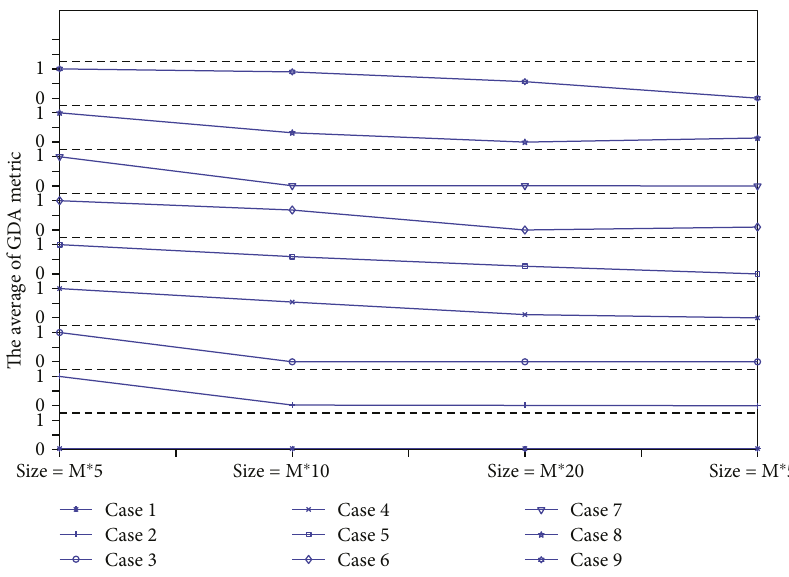
Figure 8: Results on di ff erent population size of the average of GDA metric of the